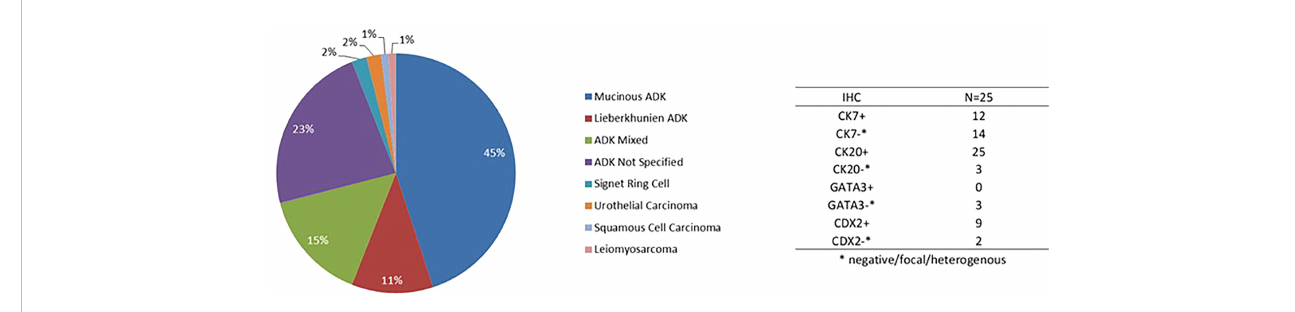
chemotherapy (Table 2), including a platin-FU combination (n=38 patients), a platin-gemcitabine combination (n=8 patients), and a platin-anthracycline combination (n=3 patients); only 6 patients received irinotecan and/or FU without platinum.